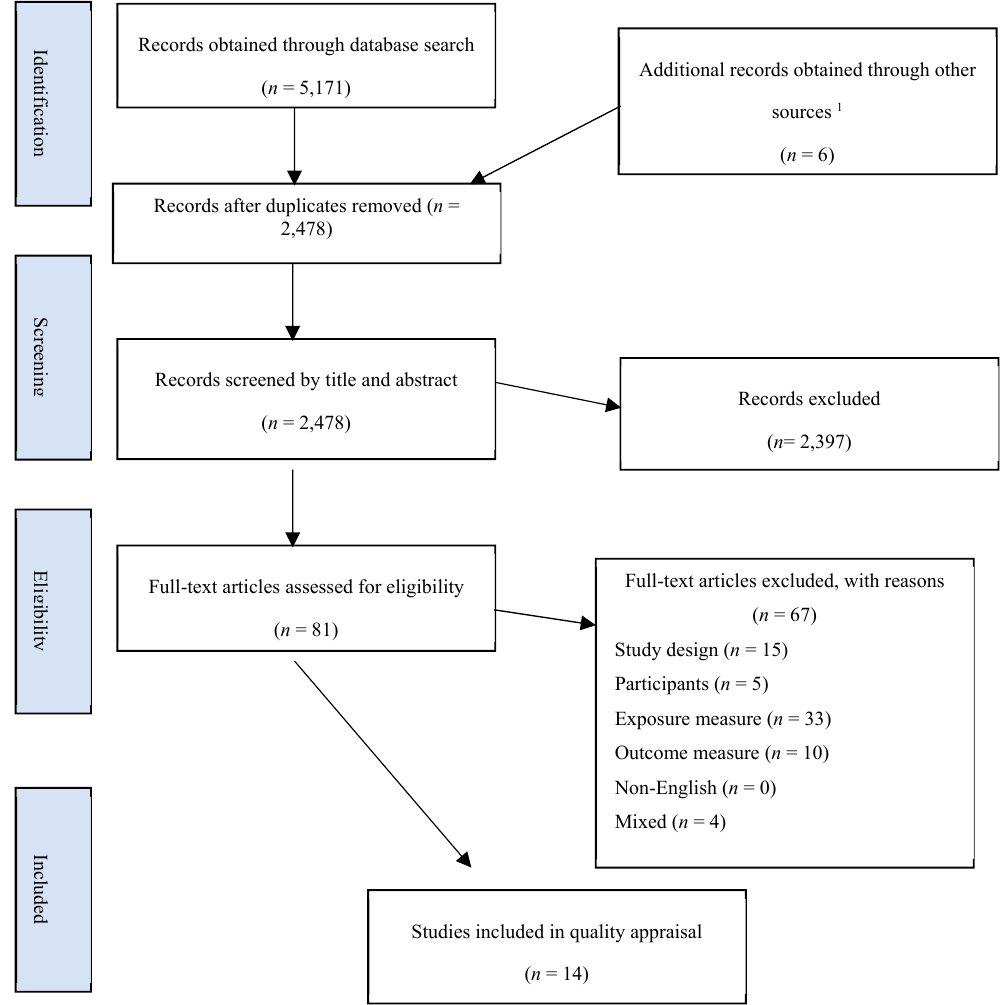
Figure 1. Flowchart of literature search and screening for selection of cohort studies exploring the impact of vegetables on anthropometric outcomes. 1 Other sources included a Google search, a hand search of reference lists of relevant systematic reviews and included studies, GRADE; Grading of Recommendations Assessment, Development and Evaluation.